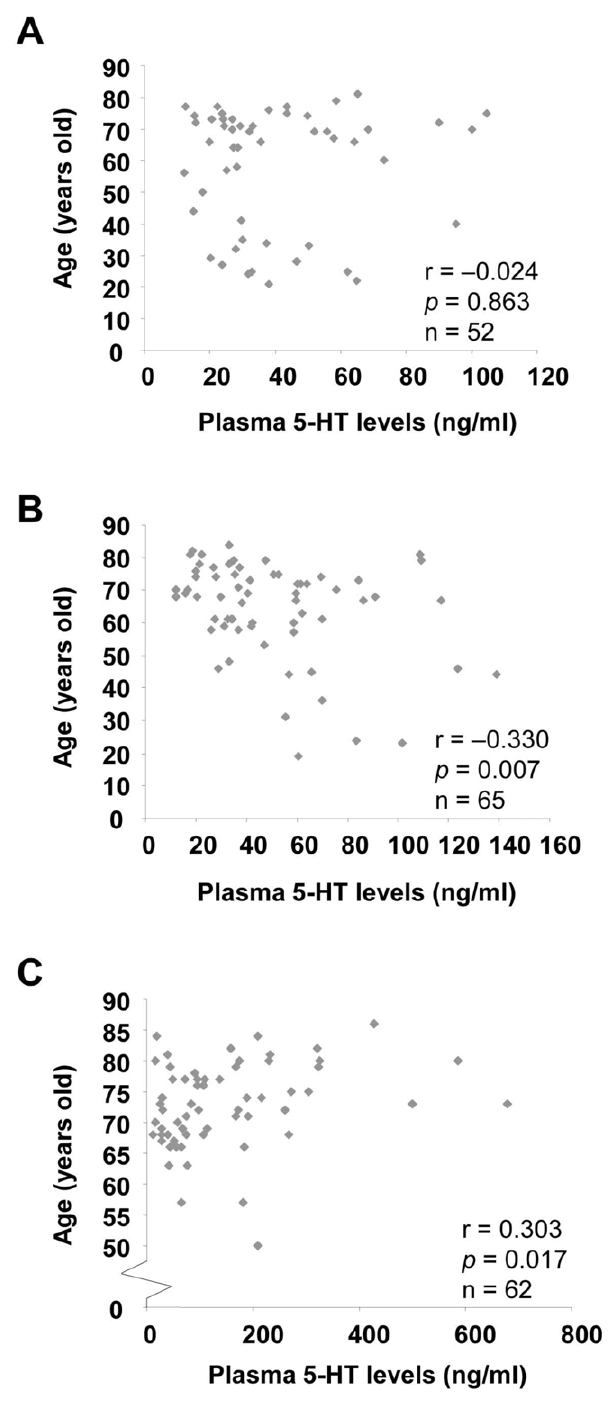
Figure 4. Spearman’s correlation between plasma 5-HT levels and age in different groups. The scatter plot of the relation between plasma 5-HT levels and age in healthy non-smokers (A), healthy ever-smokers (B) and COPD ever-smokers (C). The Spearman correlation coefficient (r) and the p value were shown.